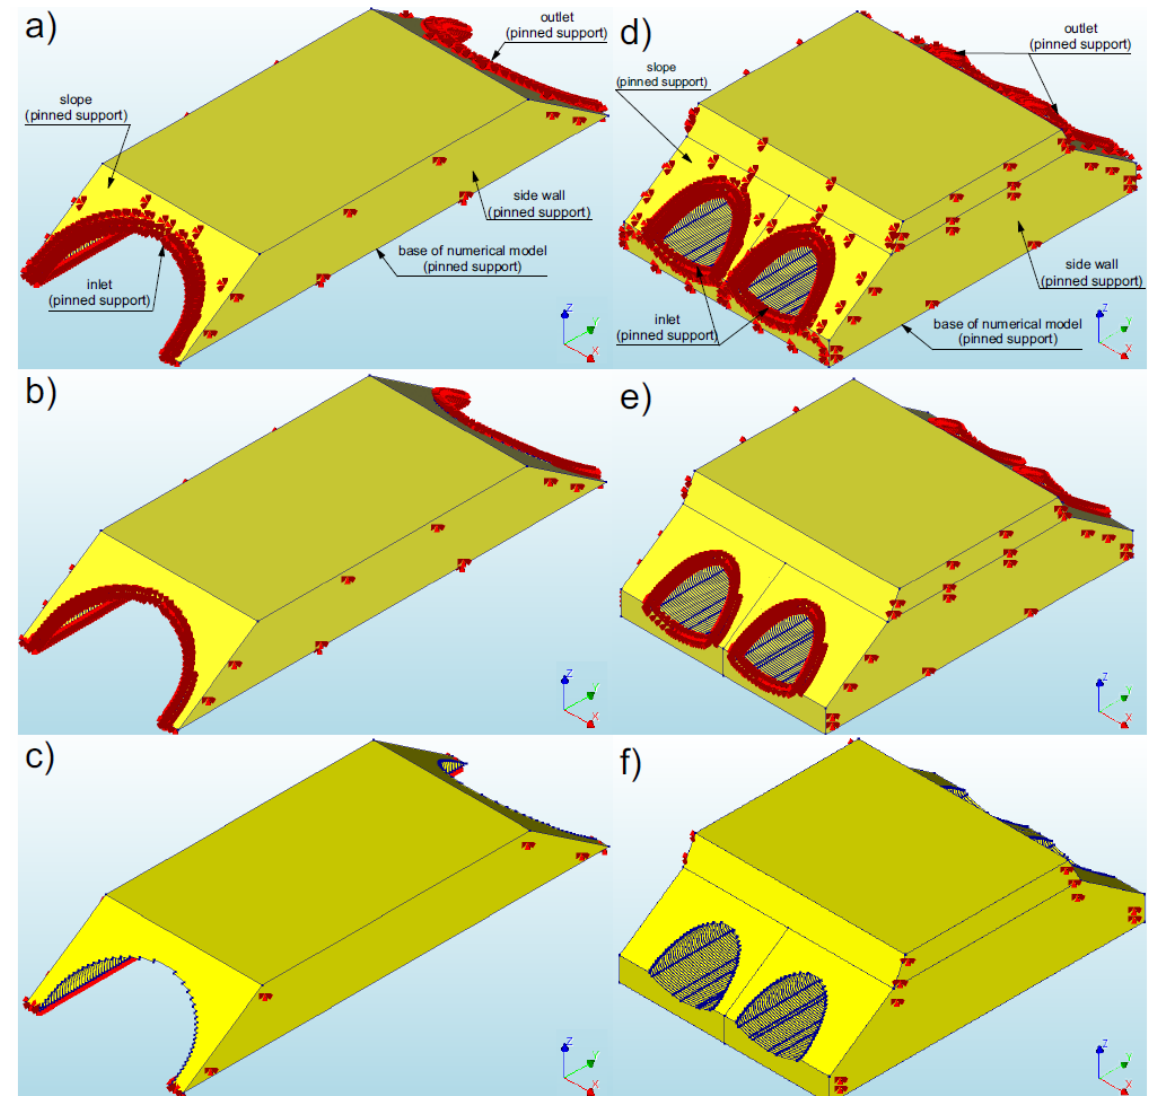
Figure 9. View of the boundary conditions for bridge #I: ( a ) model 1, ( b ) model 2, ( c ) model 3 and for bridge #II: ( d ) model 4, ( e ) model 5, ( f ) model 6.